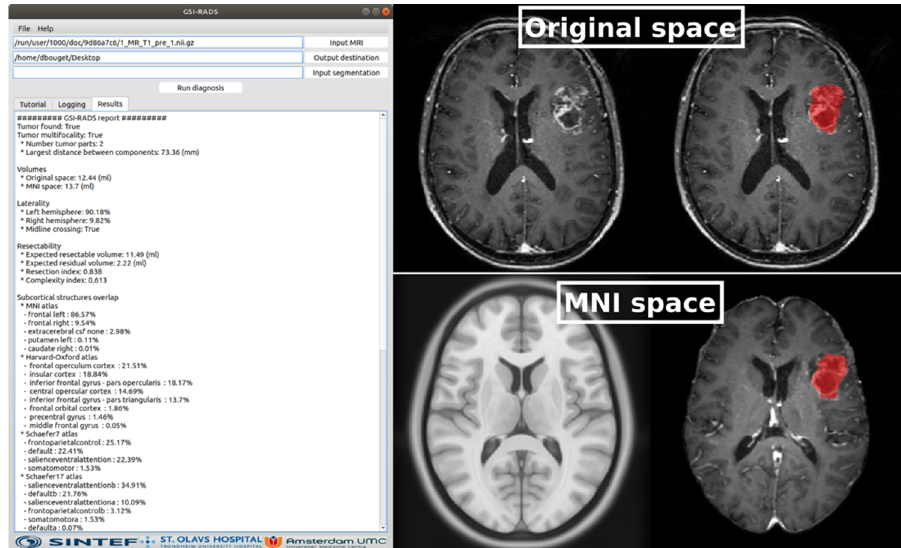
Figure 9. Illustration of the GSI-RADS software and standard report. At the left, the standard report is displayed in text format. At the top right, the patient MRI scan and the patient MRI scan with overlayed automated tumor segmentation are displayed, and at the bottom right, the standard brain space and the registered patient MRI scan with overlayed automated tumor segmentation in standard brain space are demonstrated.